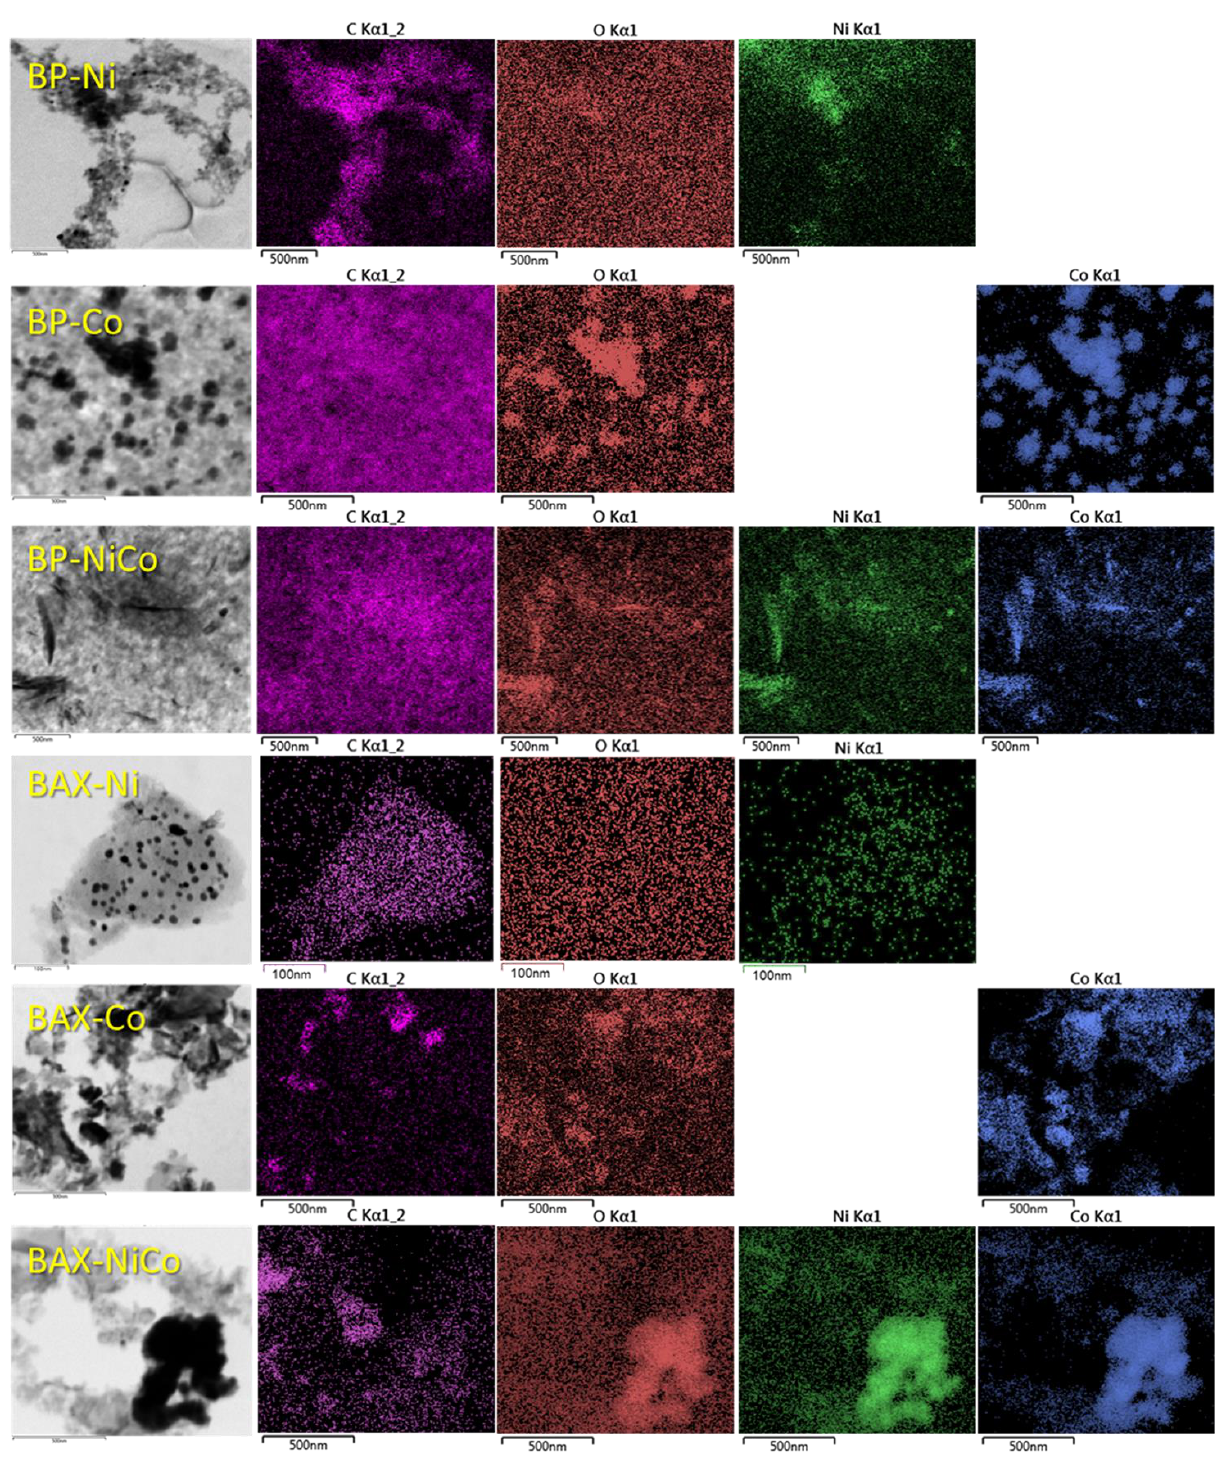
Figure 7. EDX maps of the BP and BAX series of samples.